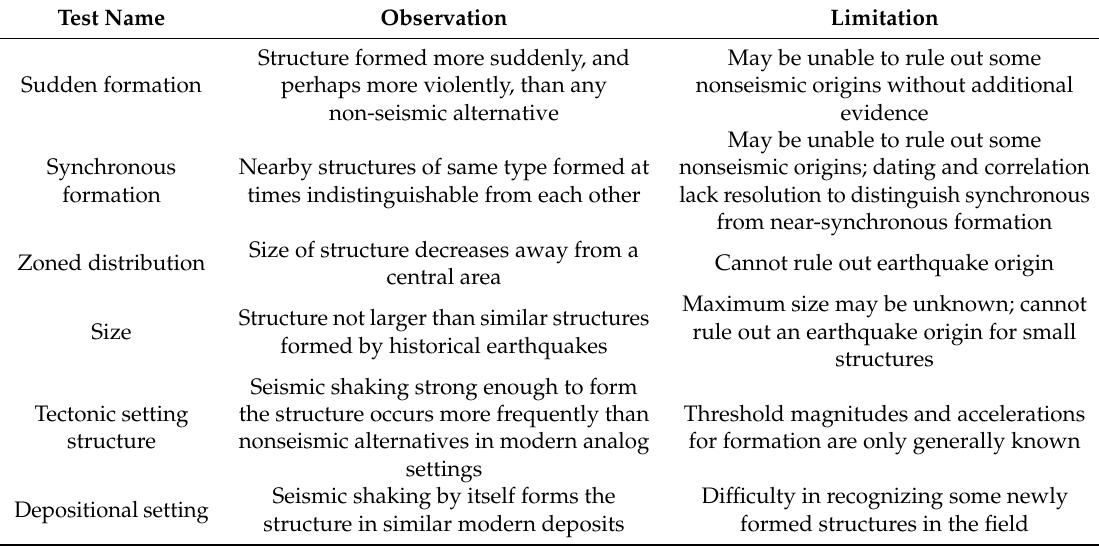
Summary of tests for determining seismic origin of soft-sediment structures (from References